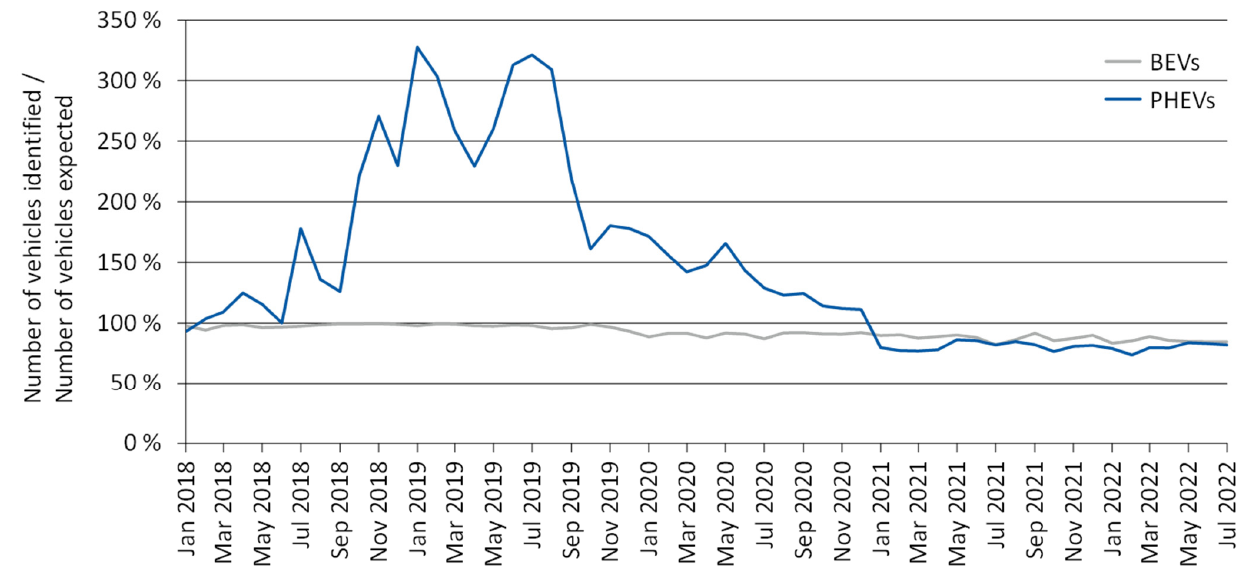
Figure 7. Number of vehicles identified divided by the number of vehicles expected to be found according to FZ28. Note that, especially in 2019 and 2020, many models were sold as PHEVs, as well as conventional combustion-engine vehicles. The high share of such mixed models explains why more models were identified that could be PHEVs than the actual number of vehicles registered in the month. For BEVs, this issue does not appear because BEV models are largely not sold in other versions.